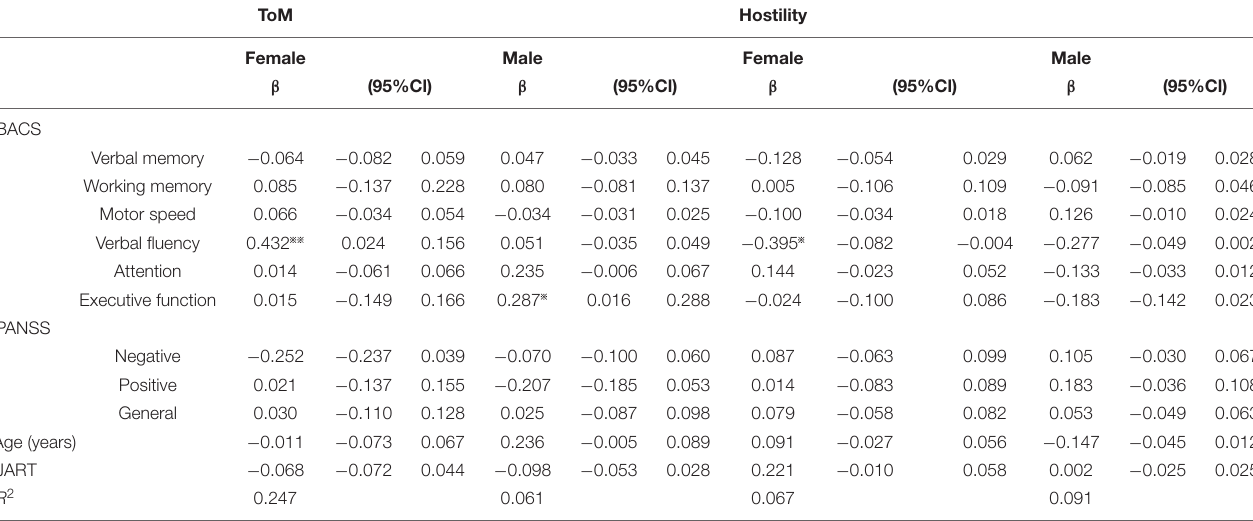
TABLE 3 | Association between neurocognitive performance and symptoms with ToM and hostility bias (multivariate